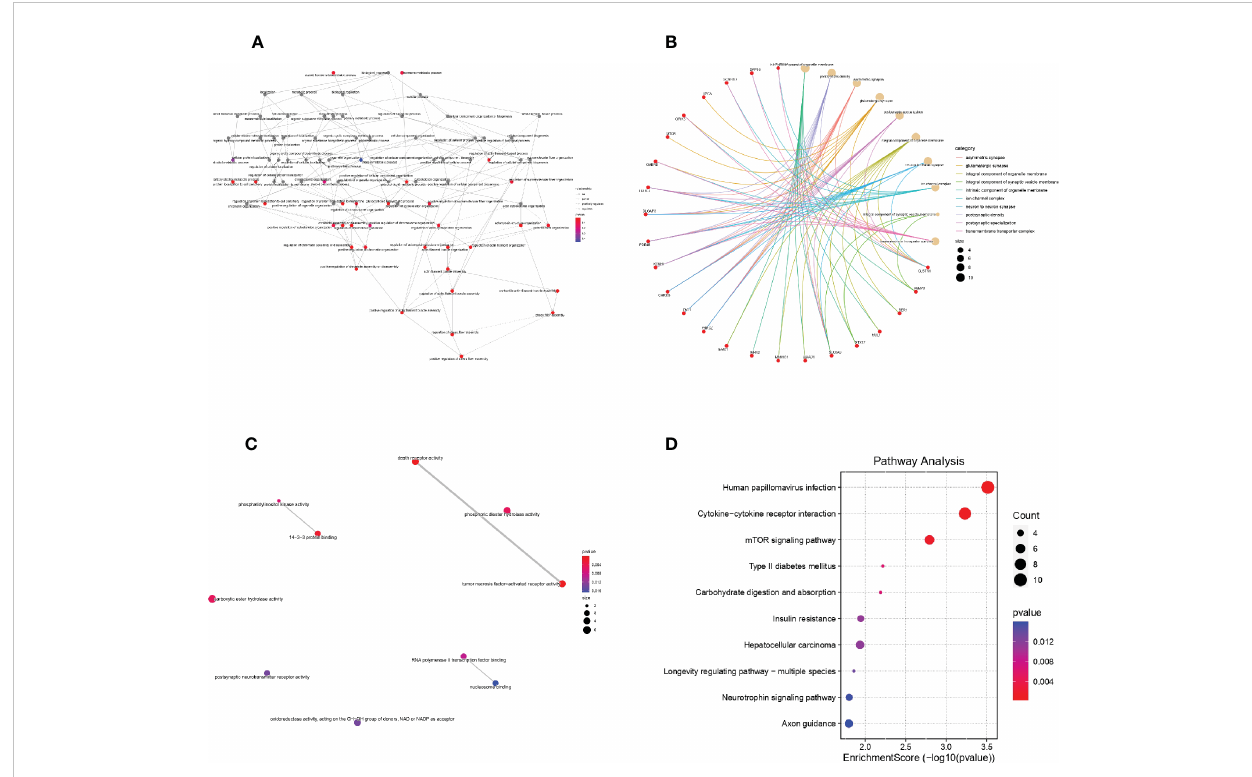
FIGURE 4 GO and KEGG analysis of DEGs (A) : Biological process of DEGs in Gene Ontology; (B) : Cellular component of DEGs in Gene Ontology; (C) : molecular function of DEGs in Gene Ontology; (D) : KEGG analysis of DEGs.